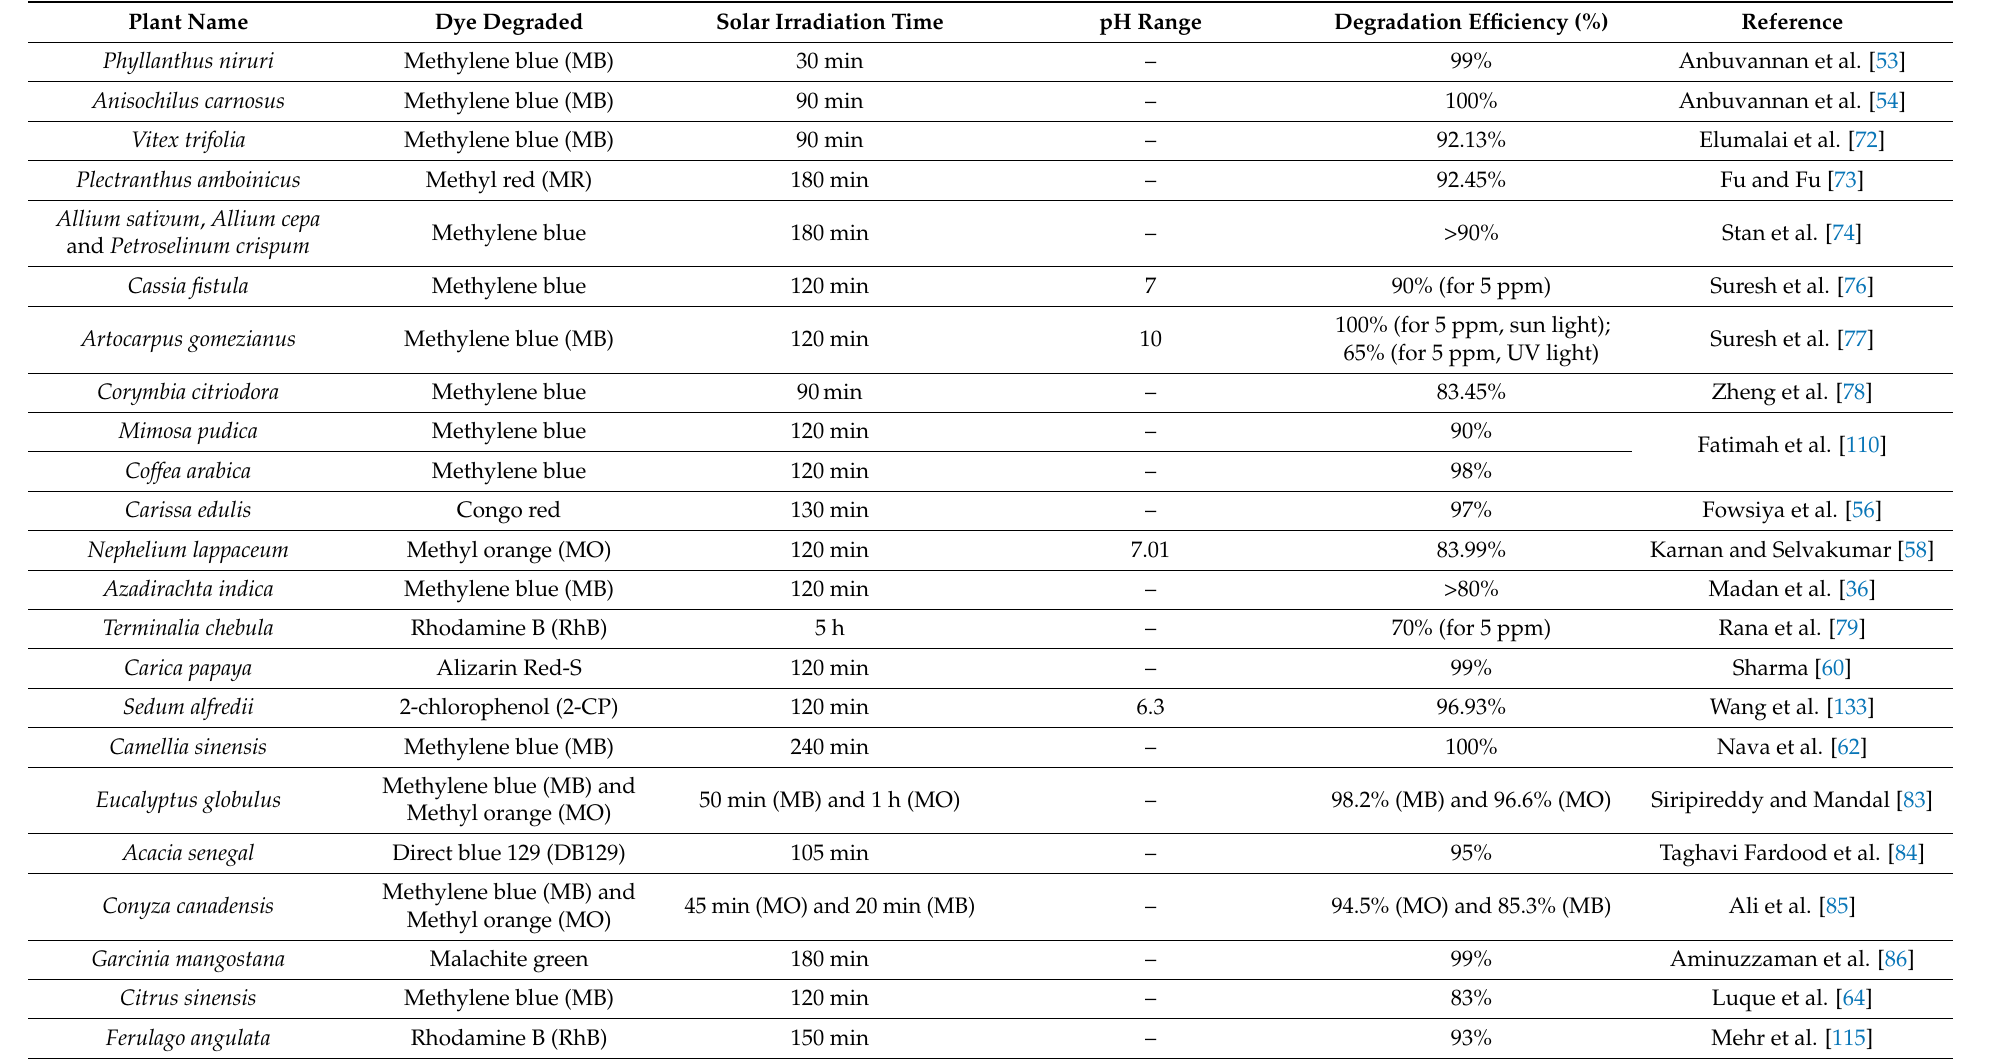
Table 7. Photocatalytic activity of the plant-mediated zinc oxide